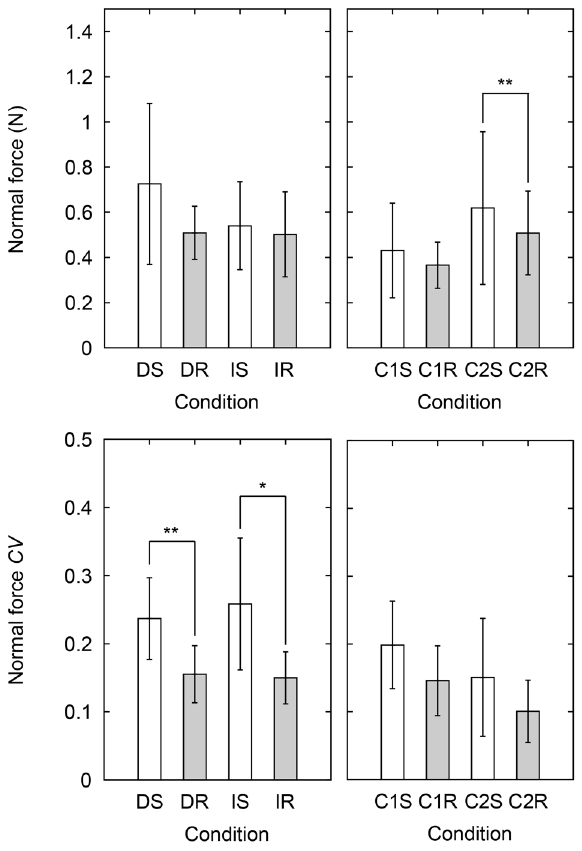
Figure 8. Averages and coefficients of variation of scanning velocity in the various conditions. Left panels: DS, DR, IS, and IR and right panels: C1S, C1R, C2S, and C2R indicate each condition. D, I, C1, and C2 mean discrimination task, identification task, 1 st control condition, and 2 nd control condition, and S and R mean smooth group and rough group. Error bars indicate the standard deviation. *indicates p , 0.05 and ** p , 0.01 with repeated measures ANOVAs.